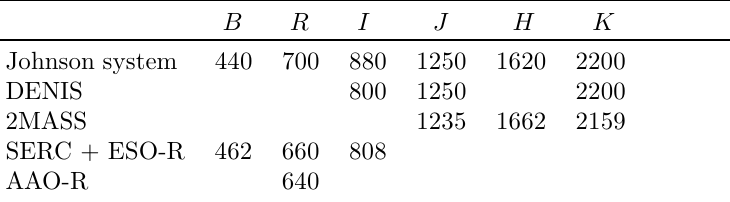
Table 2. Mean wavelengths of the used systems (in